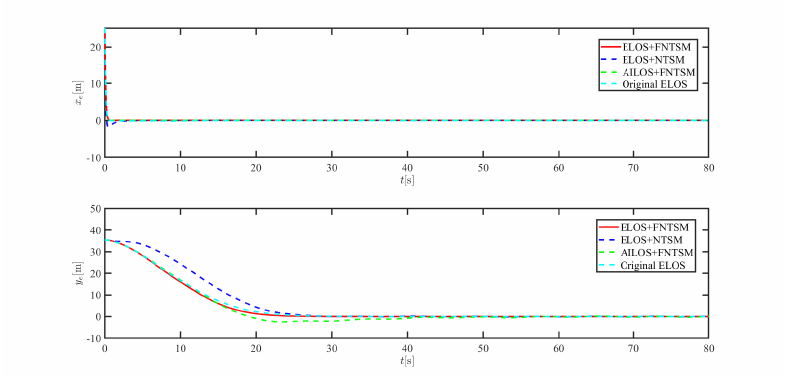
Figure 5. Along-track error x e and cross-track error y e at middle speed.